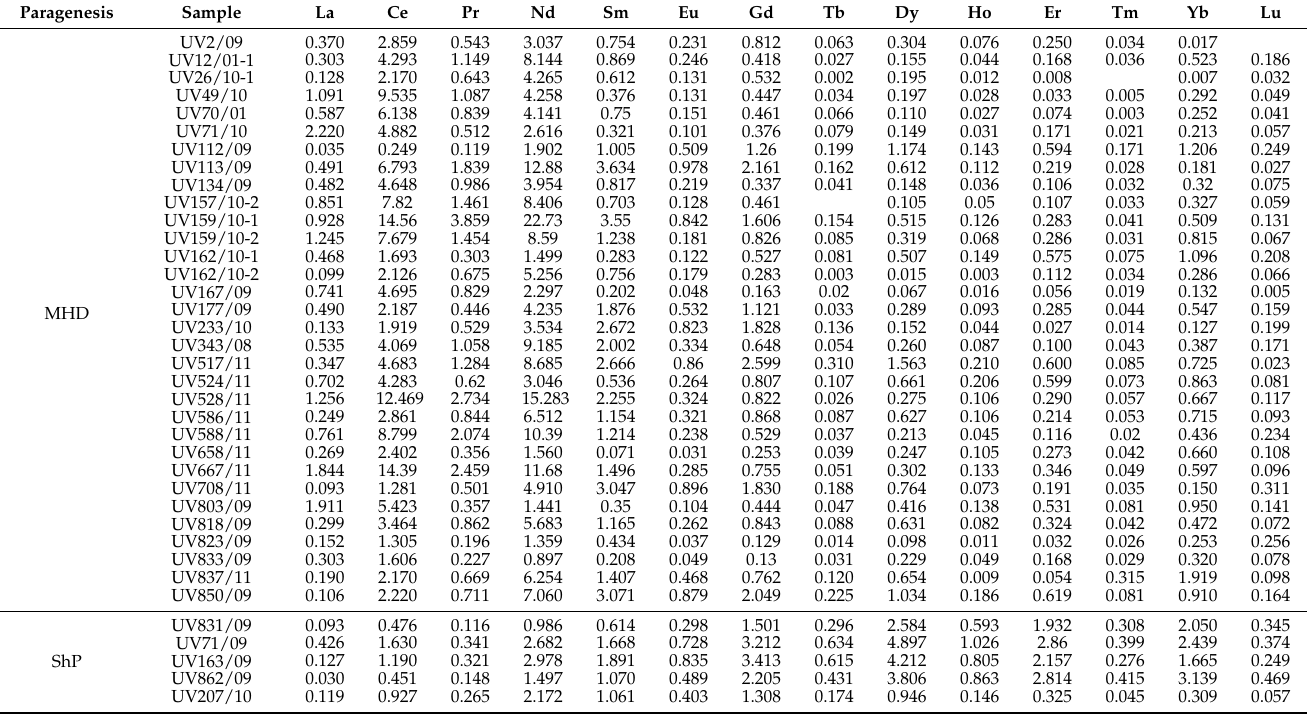
Table A2. Rare-earth composition (in ppm) of MHD and ShP garnets of Udachnaya-East kimberlite pipe (Yakutia, Russia). Paragenesis